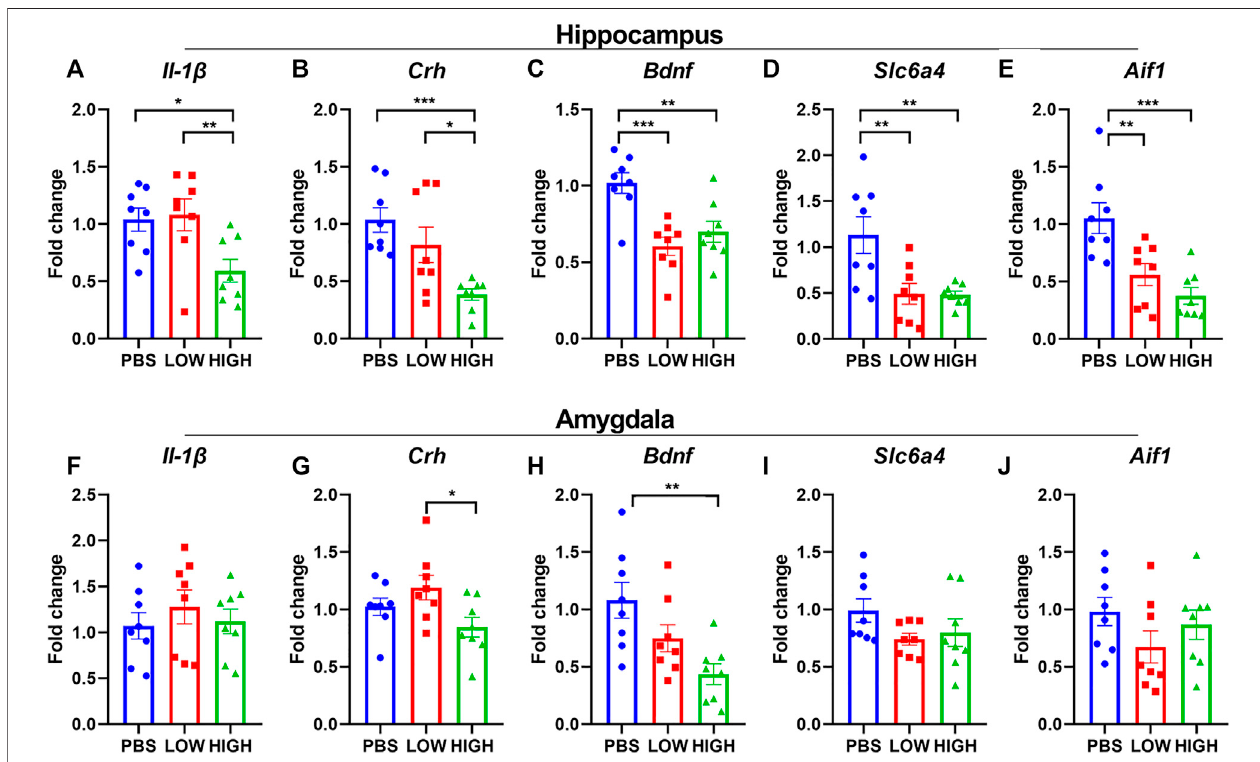
FIGURE4| EffectsofHCQonthemRNAexpressionofgenesinthehippocampusandamygdalaofmiceintheimmediategroup. (A – E) mRNAexpressionof (A) Il- 1 β (B) Crh (C) Bdnf (D) Slc6a4, and (E) Aif1 in the hippocampus (F – J) mRNA expression of (F) Il-1 β (G) Crh (H) Bdnf (I) Slc6a4, and (J) Aif1 in the amygdala ( n (cid:1) 8 for each subgroup; one-way ANOVA; * p < 0.05, ** p < 0.01, *** p <